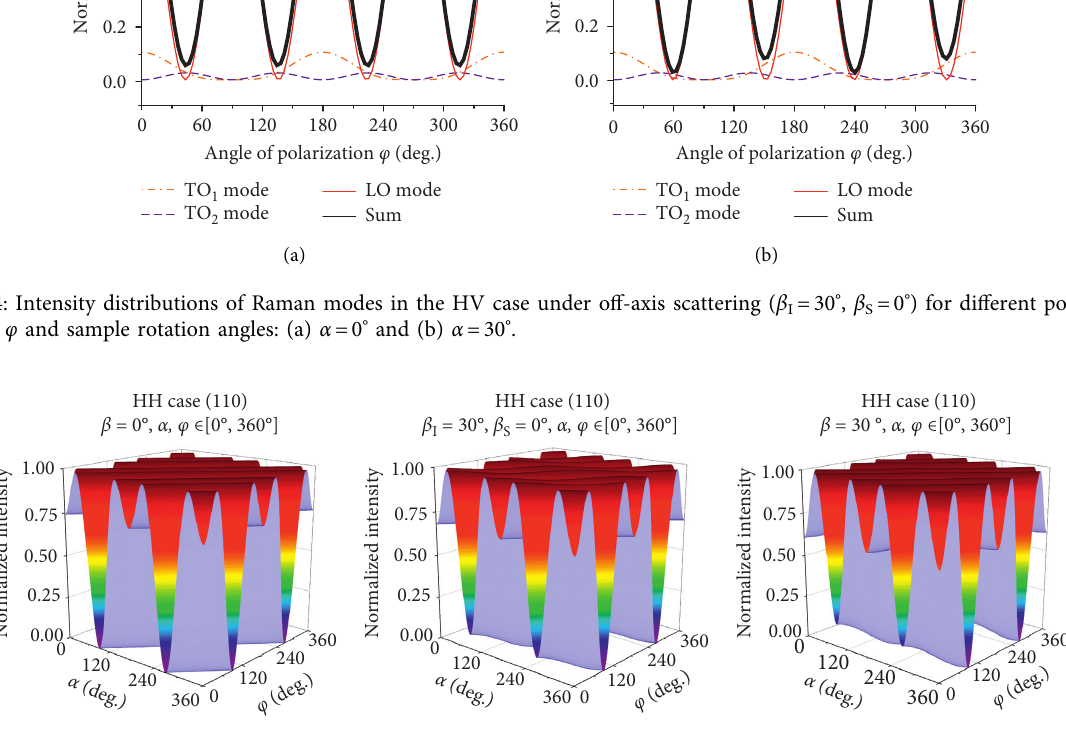
Figure 15: Intensity distributions of Raman modes of (110) c-Si in the HH case for different polarization directions φ and sample rotation angles α under (a) vertical backscattering ( β � 0 ° ), (b) off-axis scattering ( β � 30 ° ), and (c) oblique backscattering ( β I � 30 ° , β S � 0 °